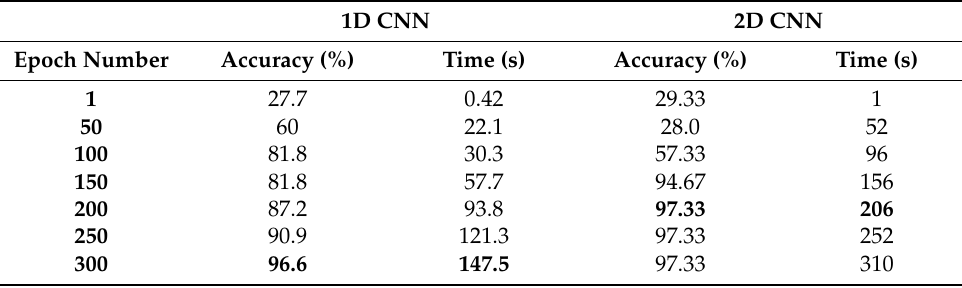
Table 1. Diagnostic accuracy with different epoch numbers for the 1D CNN and the 2D CNN. 1D CNN 2D CNN Epoch Number Accuracy (%) Time (s) Accuracy (%) Time